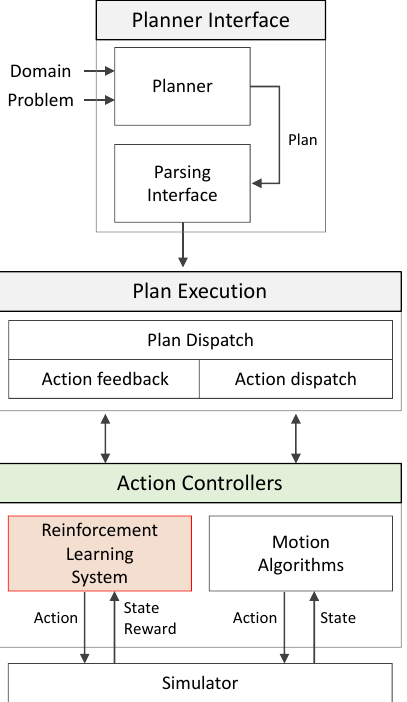
Figure 8. Plugin-based neuro-symbolic framework: Actions generated through a planner are de- livered to the action controller through plan execution. Here, agents are removed through the reinforcement learning system if actions requiring a quick response are received. All other actions are applied with motion planning based on motion